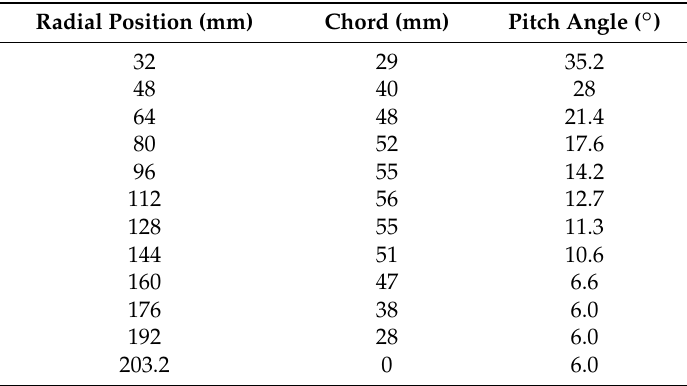
Table 2. Chord length and pitch angle of the blade.